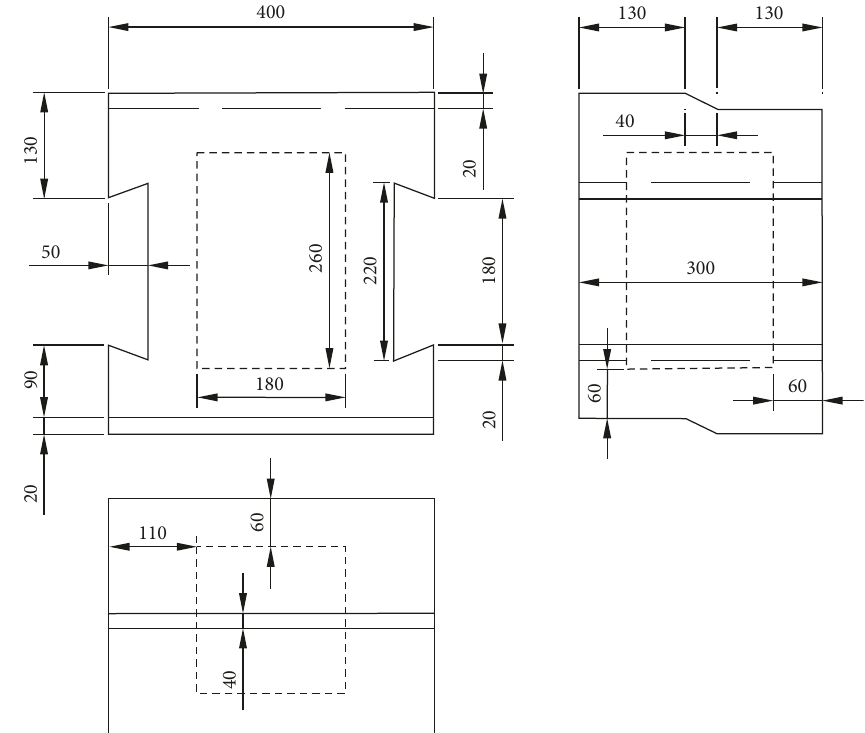
Figure 7: Three views of block